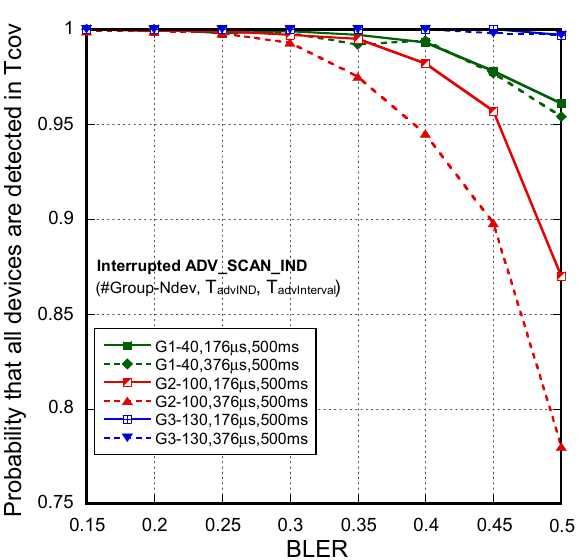
Figure 11. Interrupted scannable undirected advertisement scheme. Probability that all devices are detected under a single scanner coverage. Comparison between Group #1 ( 1 ), #2 ( 2 ), #3 ( 3 ) and #4 ( 4 ). Cases without a 100% of detection probability.